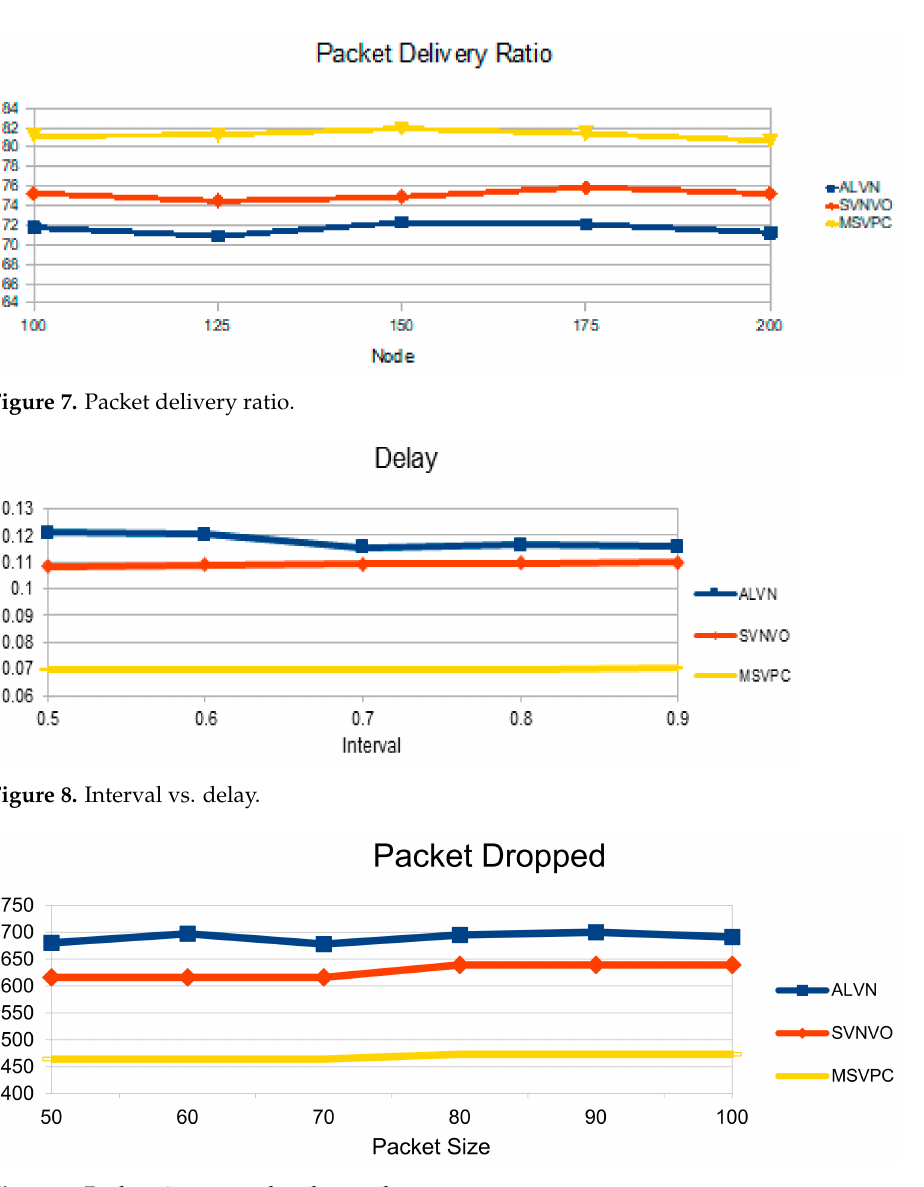
Figure 9. Packet size vs. packet